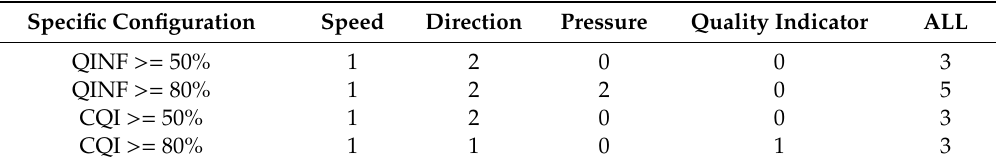
Table 19. Similarities found in the AMV datasets by the ‘paired t-test’ for the di ff erent combinations of variables and AMV datasets, in Experiment 2 (with specific